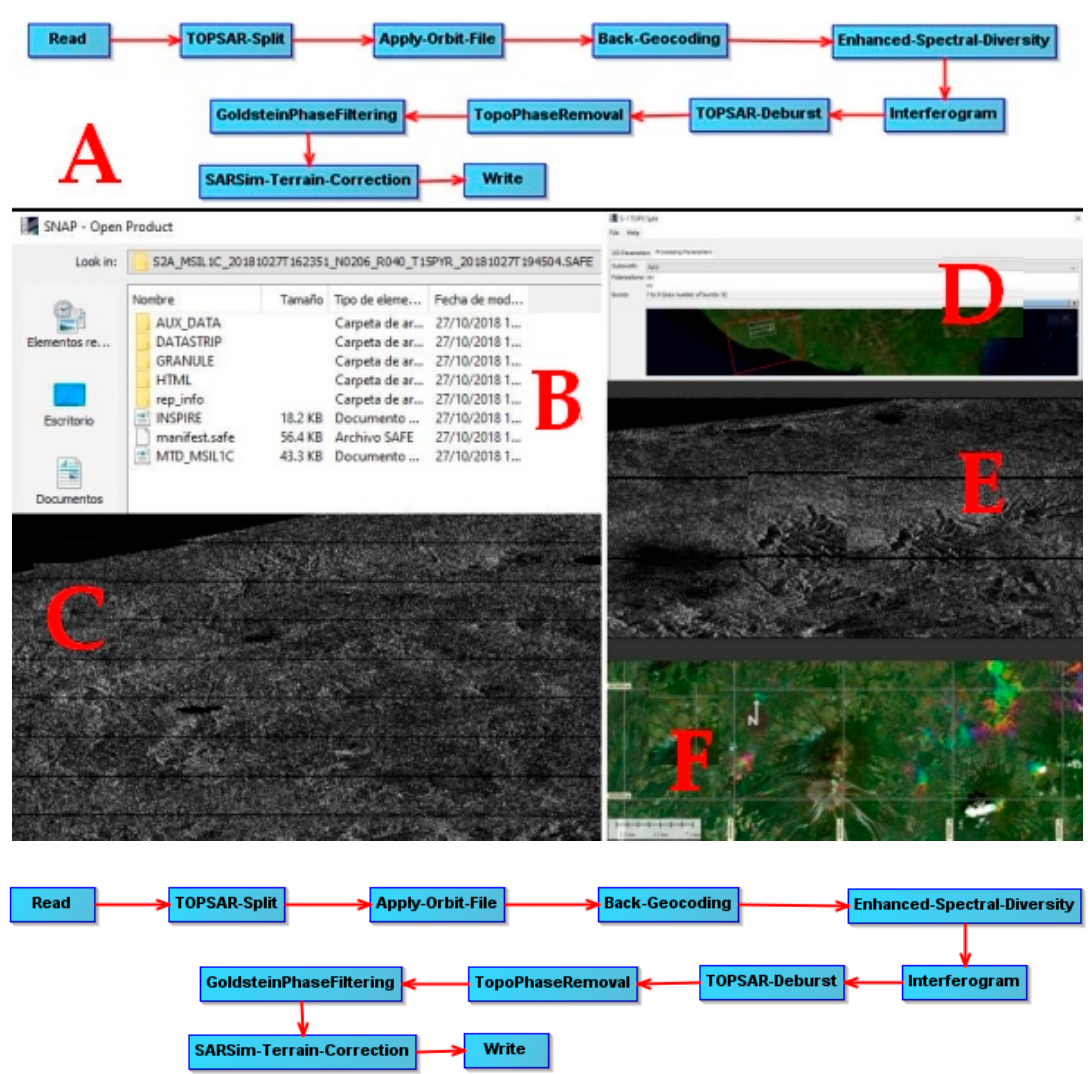
Figure 5. ( A ) The Sentinel Application Platform (SNAP) process used to obtain the deformations of the relief by DINSAR analysis. Steps ( B – F ). Sentinel Application Platform (SNAP) passages of each portion of the routine. See text for further explanation.